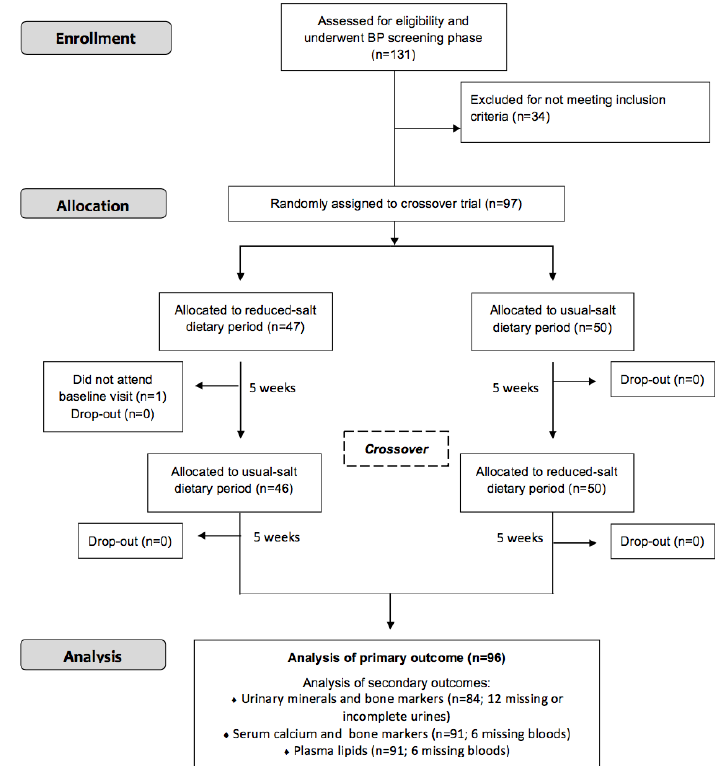
Figure 1. CONSORT flow diagram of participants. Table 2. Blood pressure, urinary, and serum biochemical variables in adults with mildly to moderately elevated blood pressure ( n 96) during the reduced-salt and usual-salt dietary